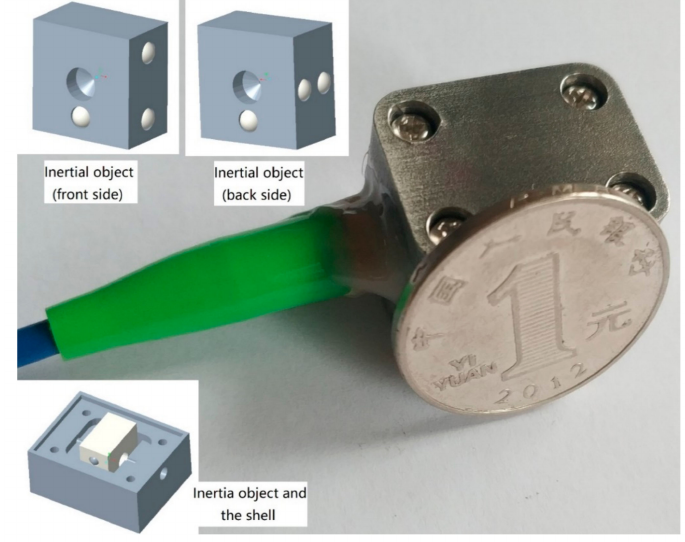
Figure 1. Ultra-small FBG accelerometer (insets: its schematic